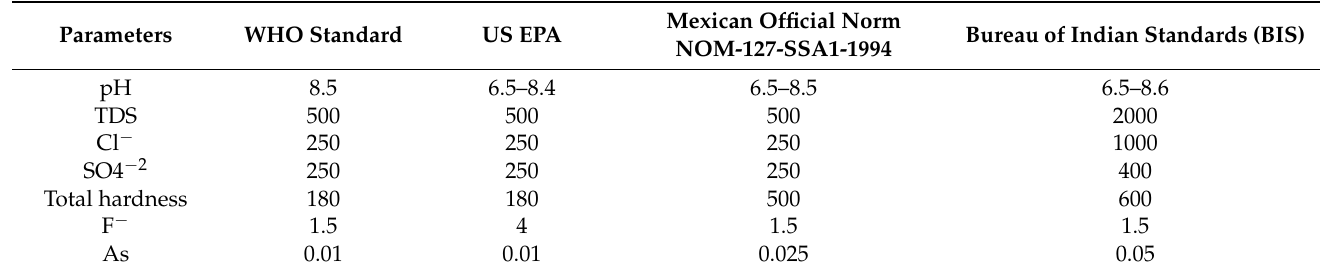
Table 1. Comparison of parameter concentrations (mg/L).